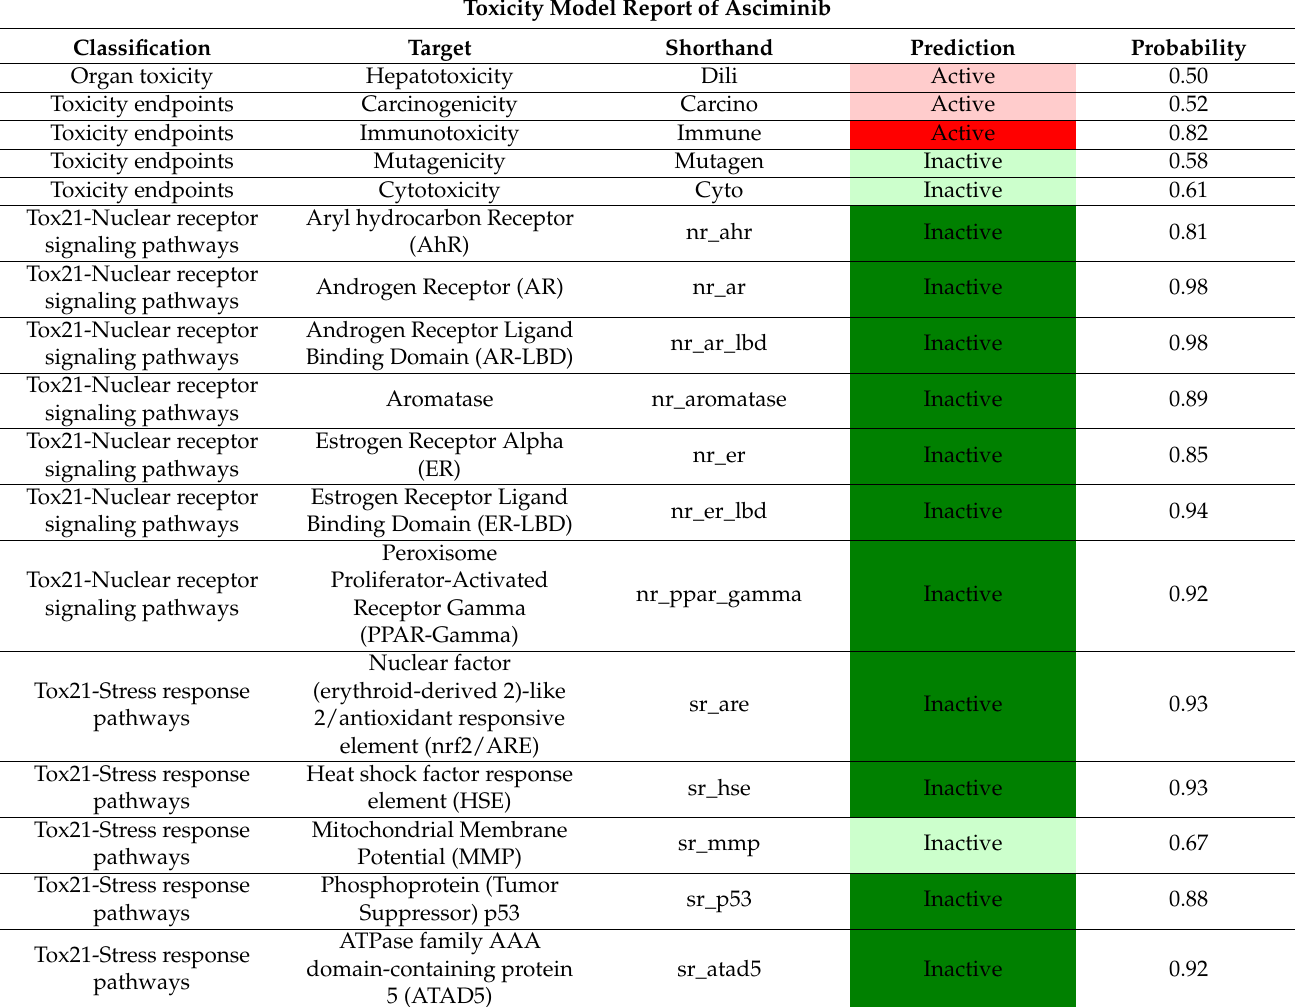
Table 4. The toxicity analysis of asciminib from